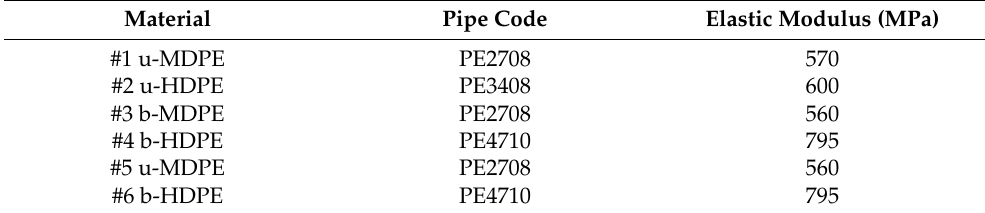
Figure 6. Simulation of the elastic modulus: an example of curve fitting for the PE #1 pipe. Table 2. Elastic modulus for the six PE pipe specimens.